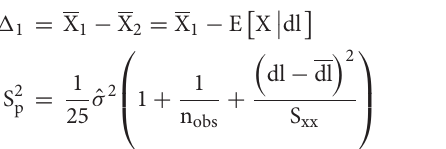
for a given number of repeat measurements (e.g., n probability of detection is evaluated as a function of damage level (dl) and significance level ( α or the probability of false